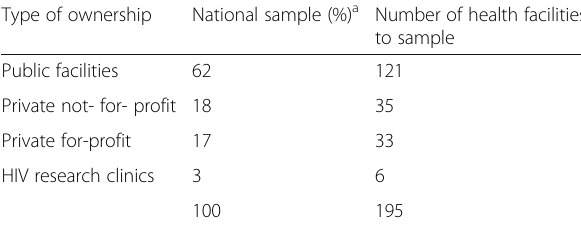
Table 1 Representation by ownership-type of health facility Type of